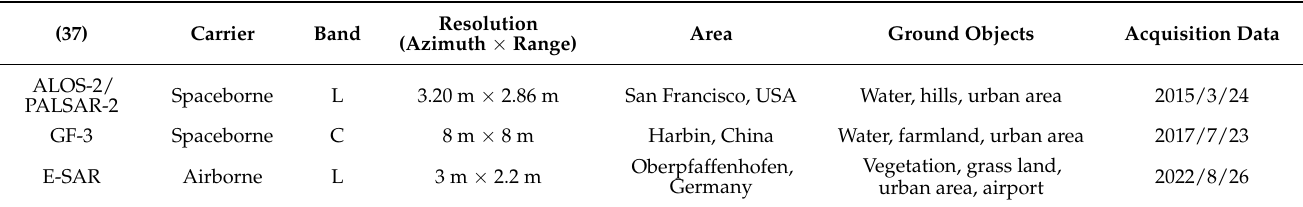
Table 1. List of fully polarimetric data